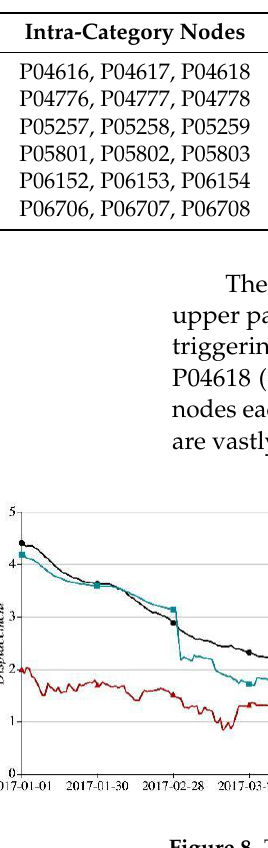
Table 2. Single region evaluation instance on September 12, 2017.